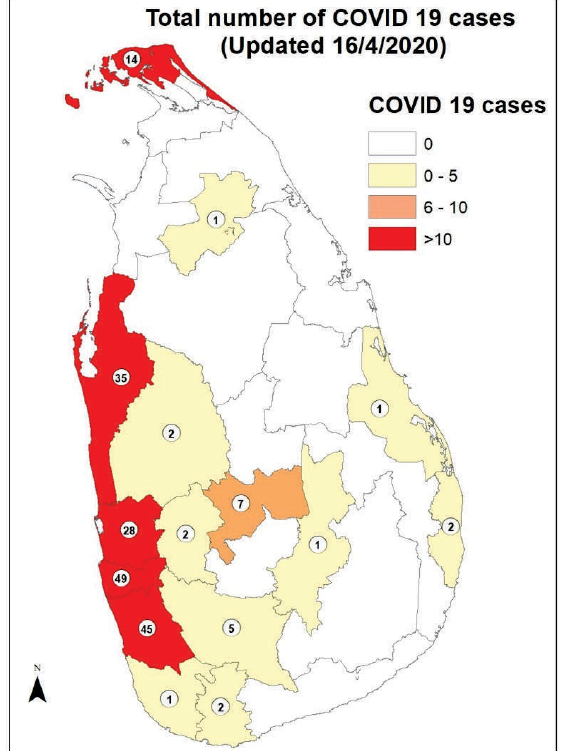
Figure 4: Risk status of districts